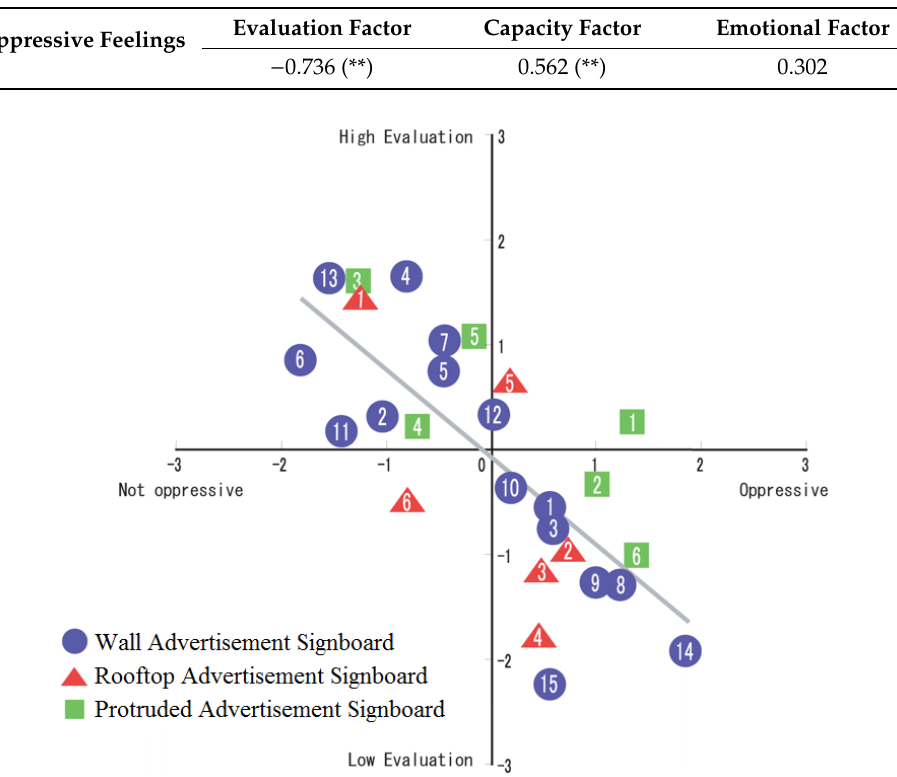
Table 9. Correlations between oppressive feelings and each factor. (**: p < 0.01).